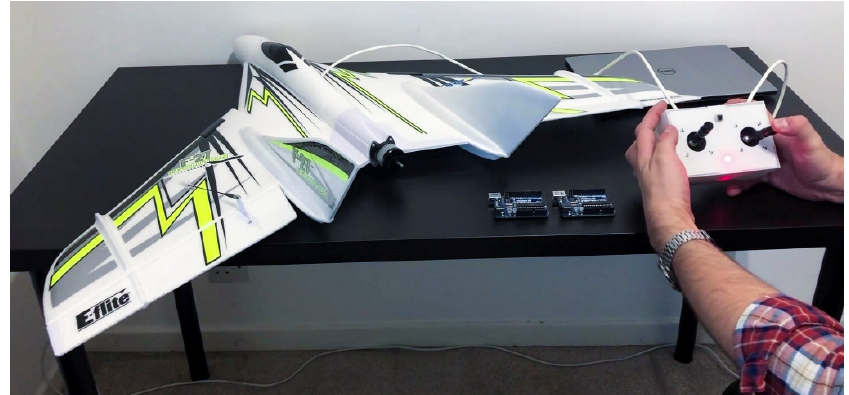
Figure 4. Remote-controlled drone setup.